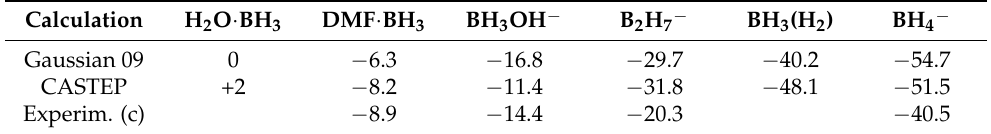
Table 2. Chemical shifts ( δ , in ppm) for the hypothetic BH 3 -based short-living intermediates plus that of BH 4 − for comparison as calculated using Gaussian 09 and CASTEP. The experimental values for the experiment (c) are recalled, where I 1 is proposed to be DMF · BH 3 , and I 2 to be B 2 H 7 − . Calculation H 2 O · BH 3